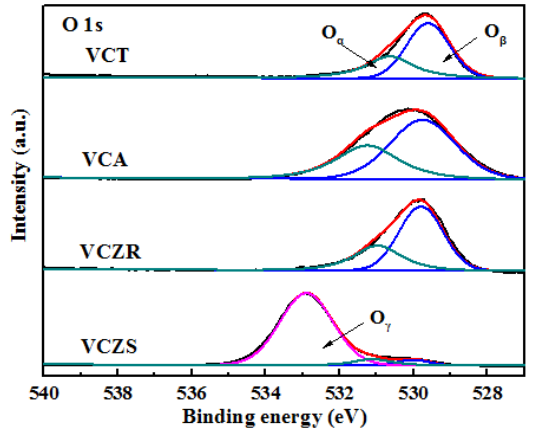
Figure3. O1sX-rayphotoelectronspectroscopy(XPS)high-resolutionscansspectraofdi ff erentsamples. Figure 3. O 1s X-ray photoelectron spectroscopy (XPS) high-resolution scans spectra of different samples. Table 2. Surface composition of the samples obtained by Table 2. Surface composition of the samples obtained by XPS.